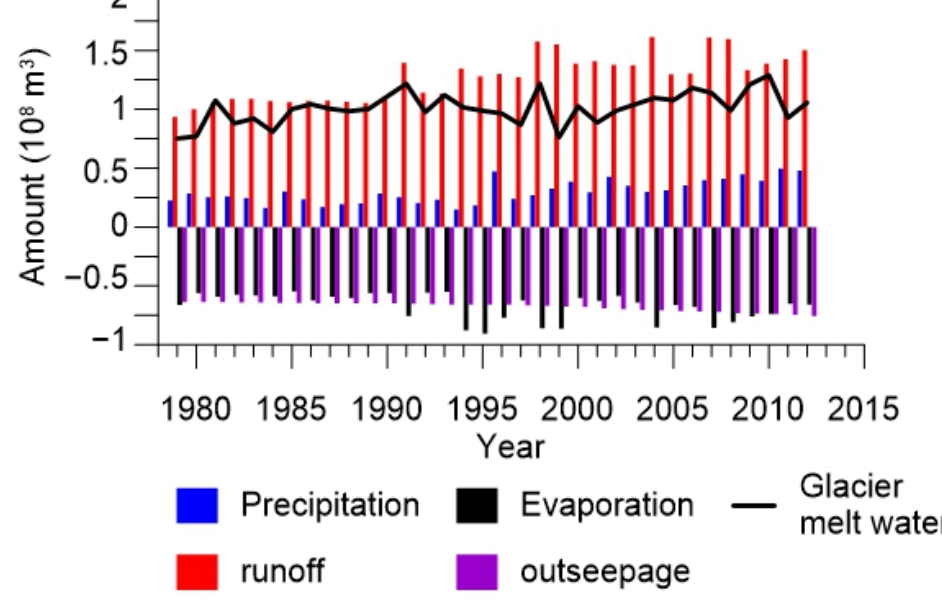
Figure 6. The amounts of different fluxes contributed to Linggo Co. The flux data are listed in Table